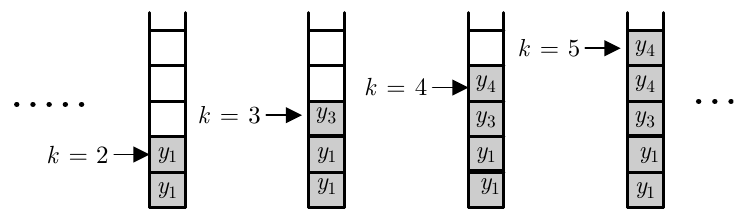
Figure 4. The configuration of the